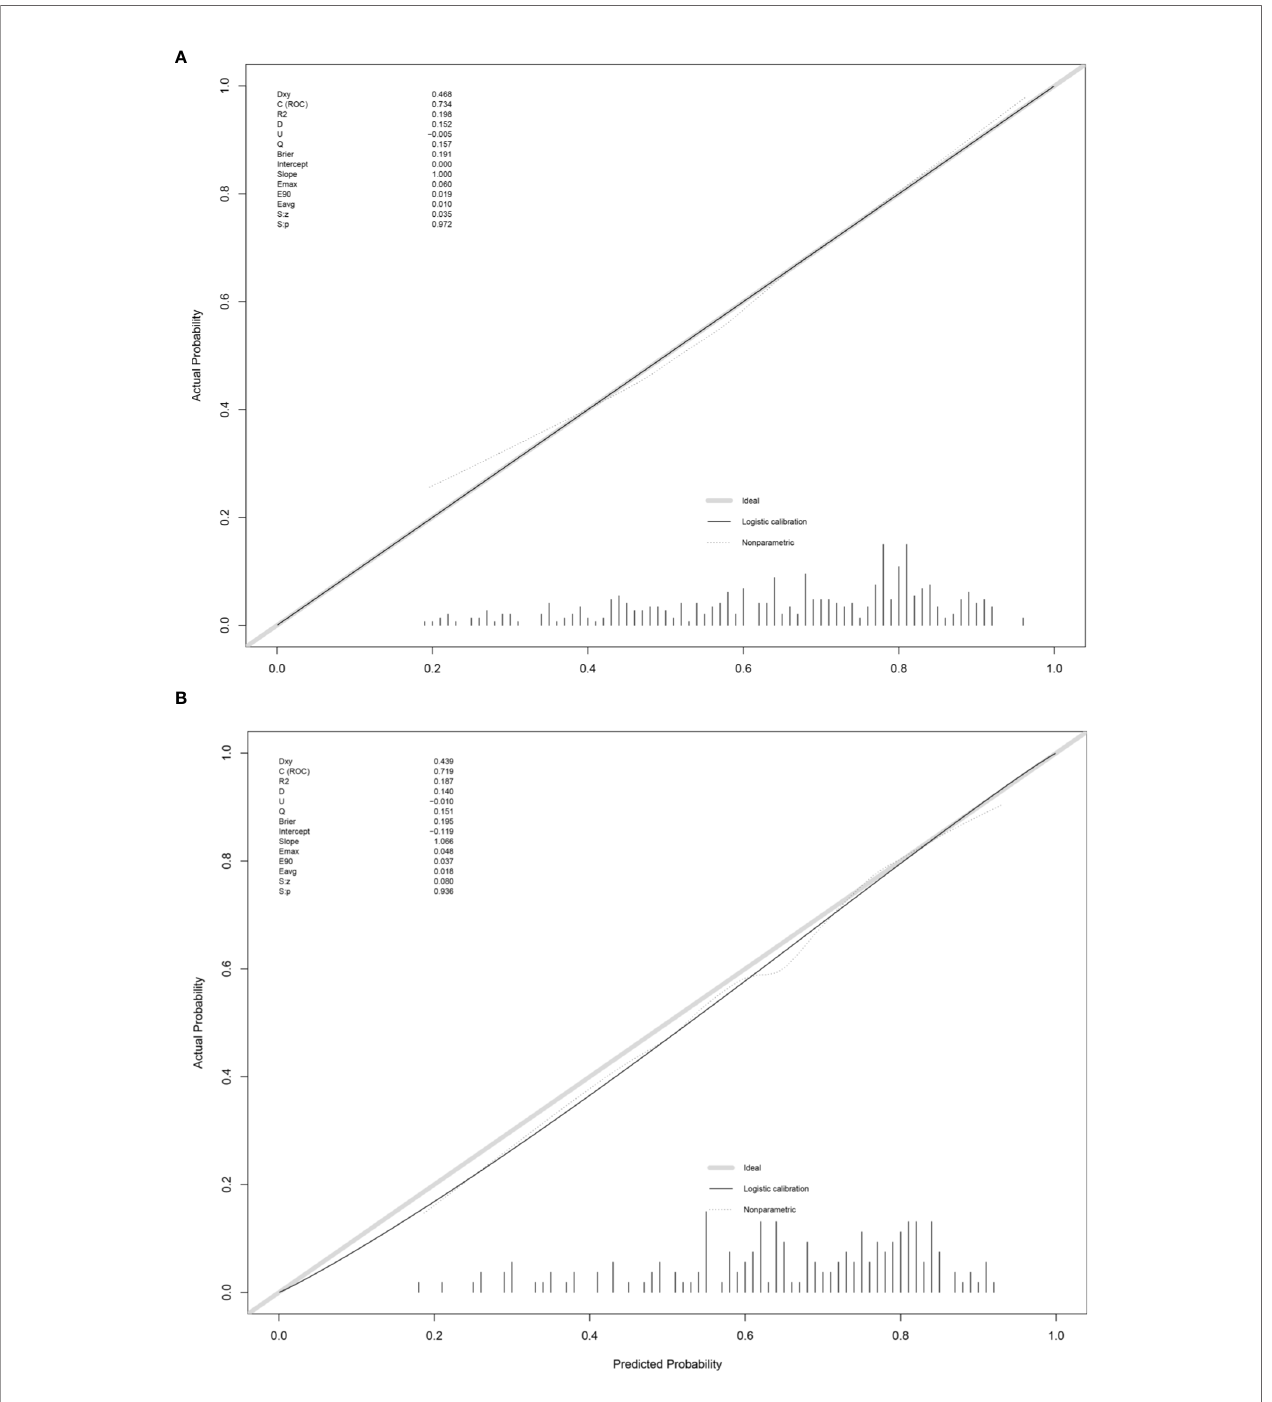
FIGURE 9 | Calibration plot of training group (A) and validation group (B)